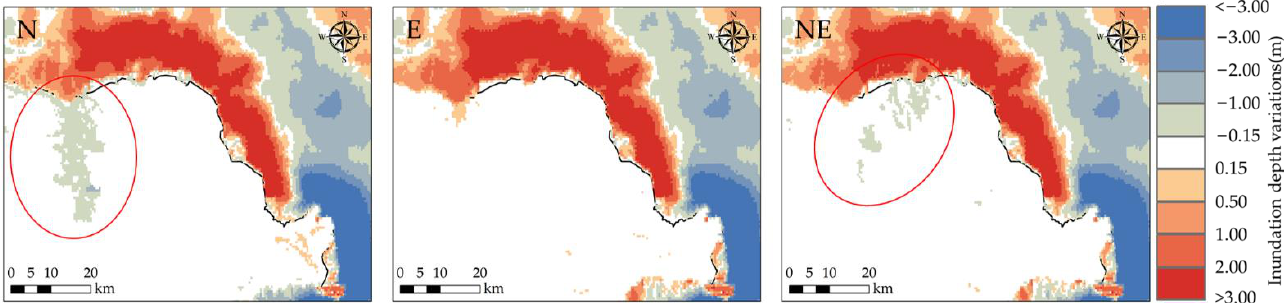
Figure 17. Bathymetric profiles of three cross-sections at Diaokou. (( a ): Locations of cross-sections; ( b ): Line 1; ( c ): Line 2; ( d ): Line 3).